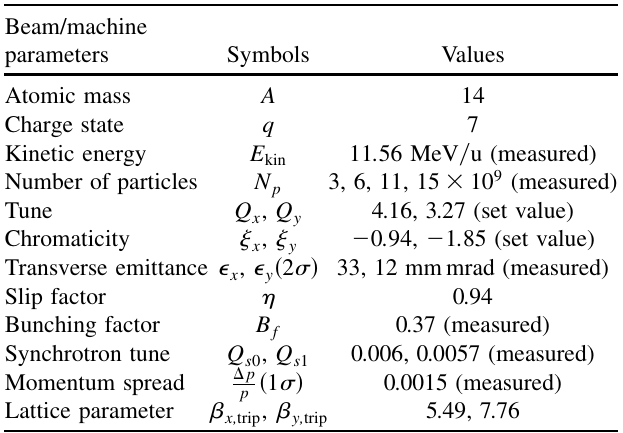
TABLE II. Beam parameters during the N 7 þ